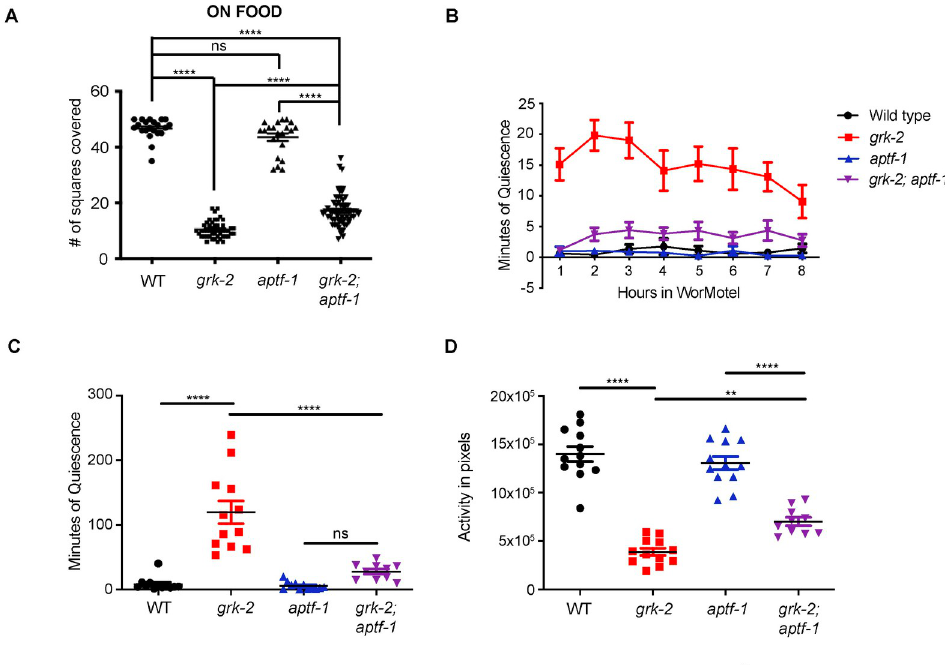
Fig 5. aptf-1 partially suppresses the exploration defect, movement quiescence, and reduced activity of grk-2 . (A) The aptf-1(gk794) mutation partially suppresses the exploration defect of grk-2(gk268) mutant. Shown is the number of squares single animals covered in ~20 h. ( ���� , P < 0.0001. ns, P > 0.05. One way ANOVA followed by a Bonferroni test. Error bars = SEM; n = 21–62). (B) grk-2(gk268) mutant animals show enhanced movement quiescence, and the aptf-1 (gk794) mutation partially suppresses this phenotype. The graph shows the average minutes animals spent in quiescence per hour in the WorMotel. Quiescence is the time when zero pixels moved between two frames separated by 10 sec (See Methods). (C) grk-2(gk268) mutant animals show enhanced movement quiescence, and the aptf-1(gk794) mutation partially suppresses this phenotype. The graph shows the total minutes individual animals spent in quiescence in 8 h in the WorMotel. ( ���� , P < 0.0001. ns, P > 0.05. One way ANOVA. Error bars = SEM; n = 10–12). (D) grk-2(gk268) mutant animals show reduced activity, and the aptf-1(gk794) mutation partially suppresses this phenotype. The graph shows